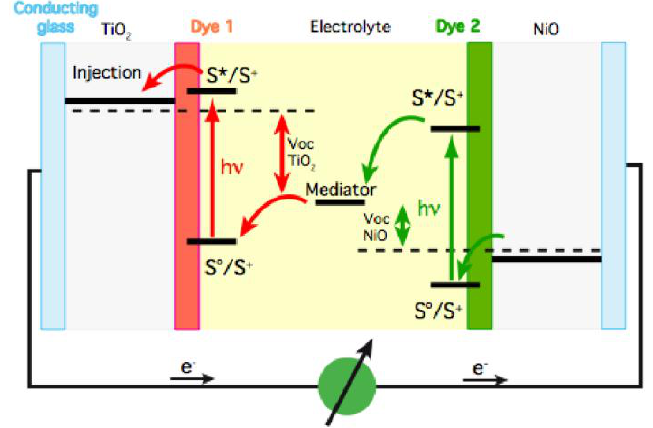
Figure 2. Operating principles of tandem dye-sensitized solar cells composed of n- and p-type semiconductors (taken from [97]).